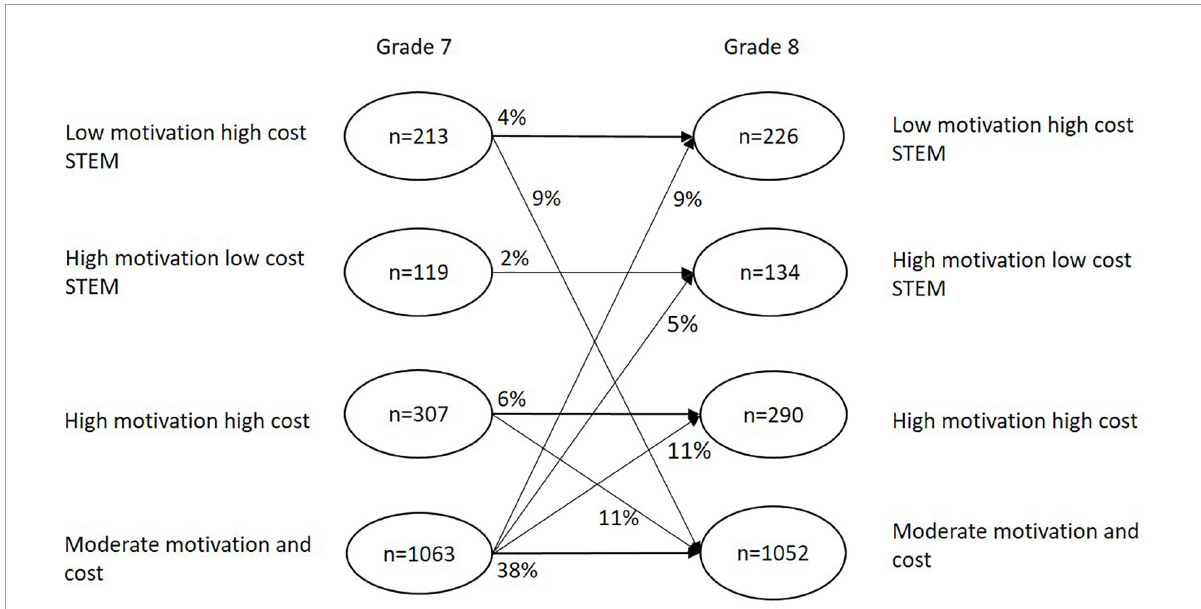
FIGURE2 Latent transition patterns with N = 1,702 cases. Only the changes that occurred in more than 4% of the total sample ( N = 1,702) with FIML estimation are depicted. All other changes are reported in Supplementary Table 1 . The numbers in the circles refer to the final class proportions for each latent class variable based on their most likely class membership. The numbers on the arrows refer to transition probabilities for the latent class changes based on the estimated model.